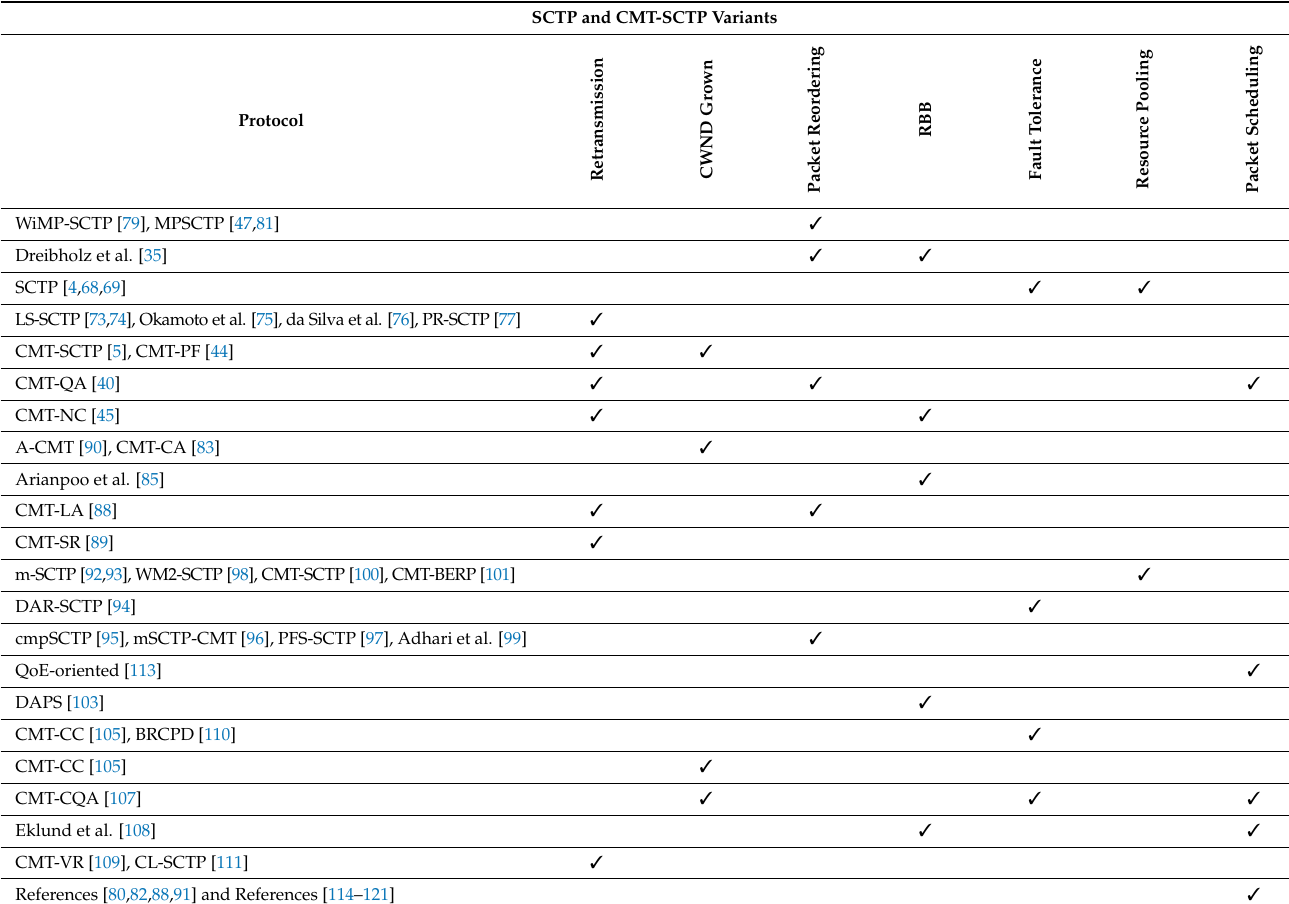
Table 2. A categorization of SCTP and CMT-SCTP transport protocols. SCTP and CMT-SCTP